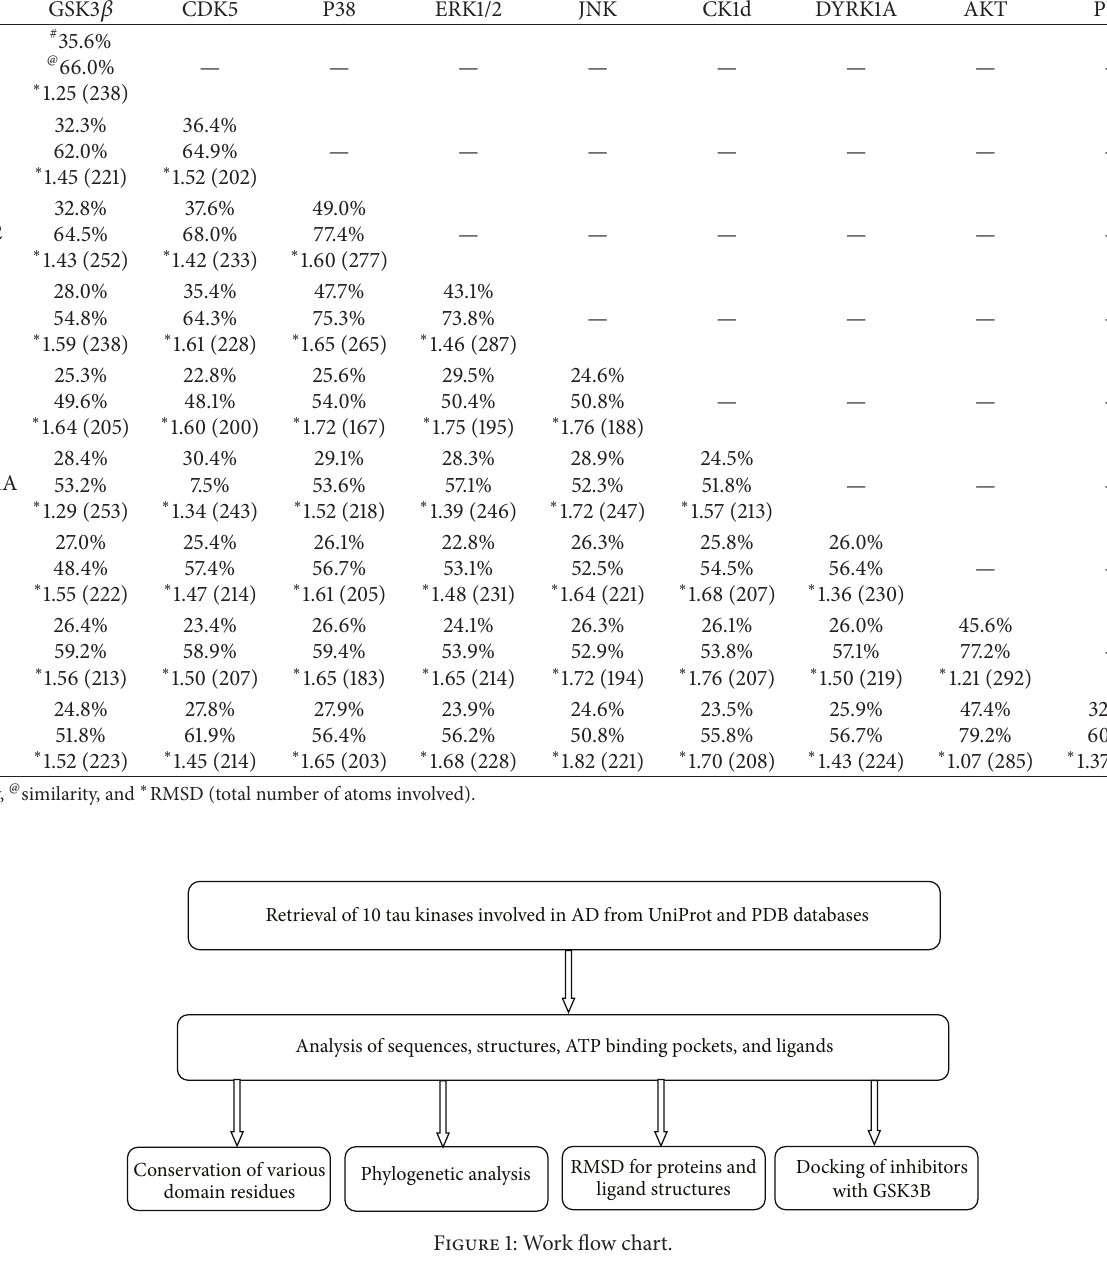
Figure 1: Work flow chart.